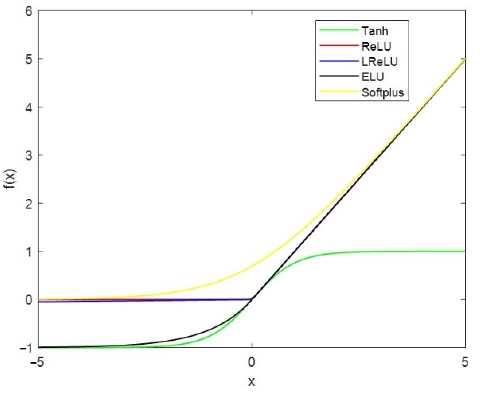
Figure 4. The waveforms of Tanh , ReLU , LReLU , ELU , and Softplus .